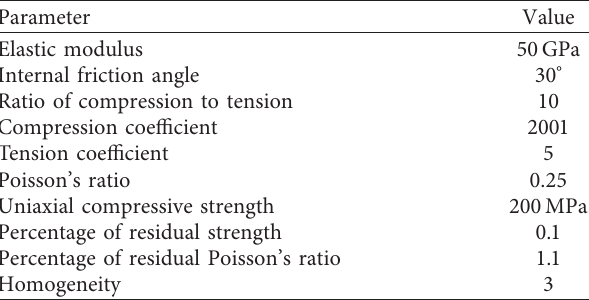
Table 2: Failure characteristic parameters used in the numerical